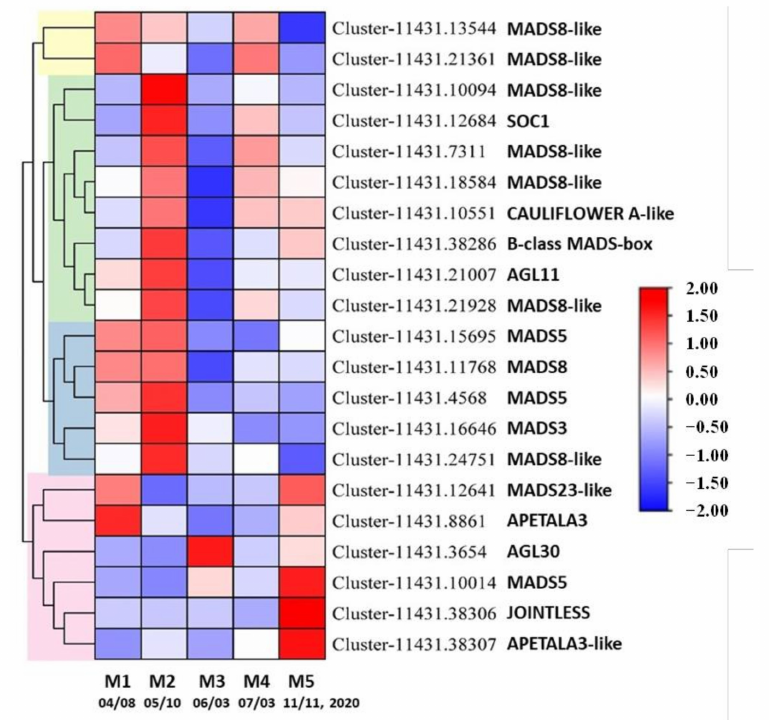
Figure 8. Differentially expressed D. pectinatum MADS-box unigenes during male cone development. SOC1: SUPPRESSOR OF OVEREXPRESSION OF CONSTANS 1; AGL: Agamous-like MADS-box protein: AP: